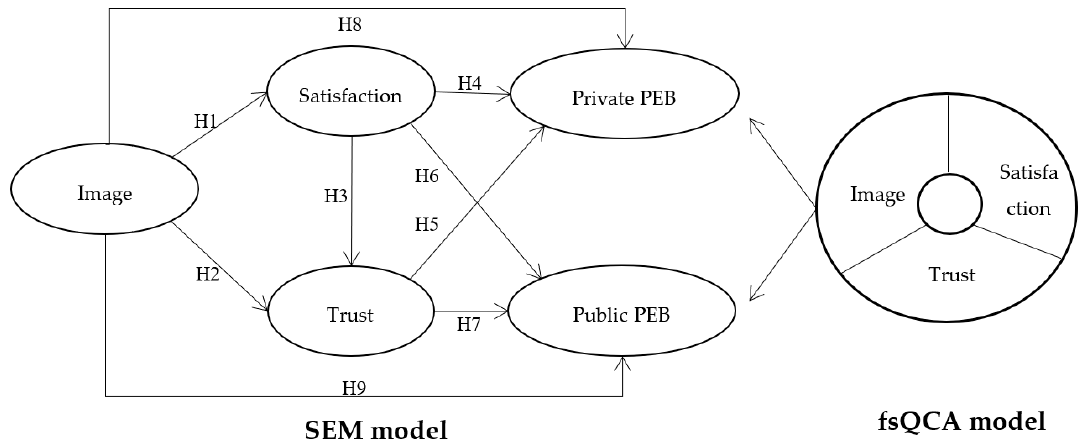
Figure 1. Conceptual model. Note: trust = destination trust; image = destination image; private PEB = private pro-environmental behavior; public PEB = public pro-environmental behavior.